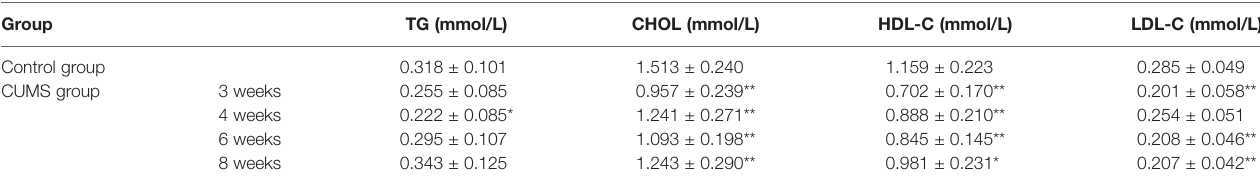
TABLE 2 | Effects of CUMS exposure on TG, CHOL, HDL-C and LDL-C.